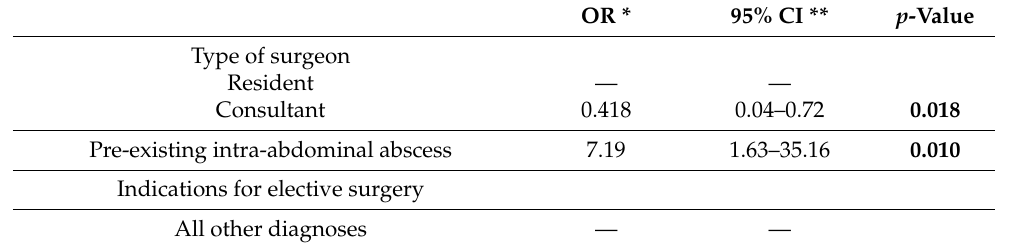
Table 7. Final logistic regression model after AIC-based forward variable selection for the subgroup of n = 141 Crohn’s disease patients. p -values are conditional on the final model